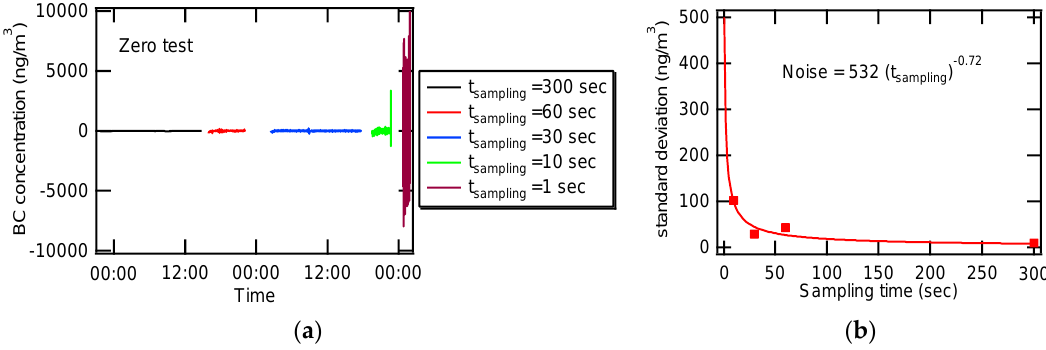
Figure 9. ( a ) Noise level increases when the sampling time is short. ( b ) Noise level is fitted to power